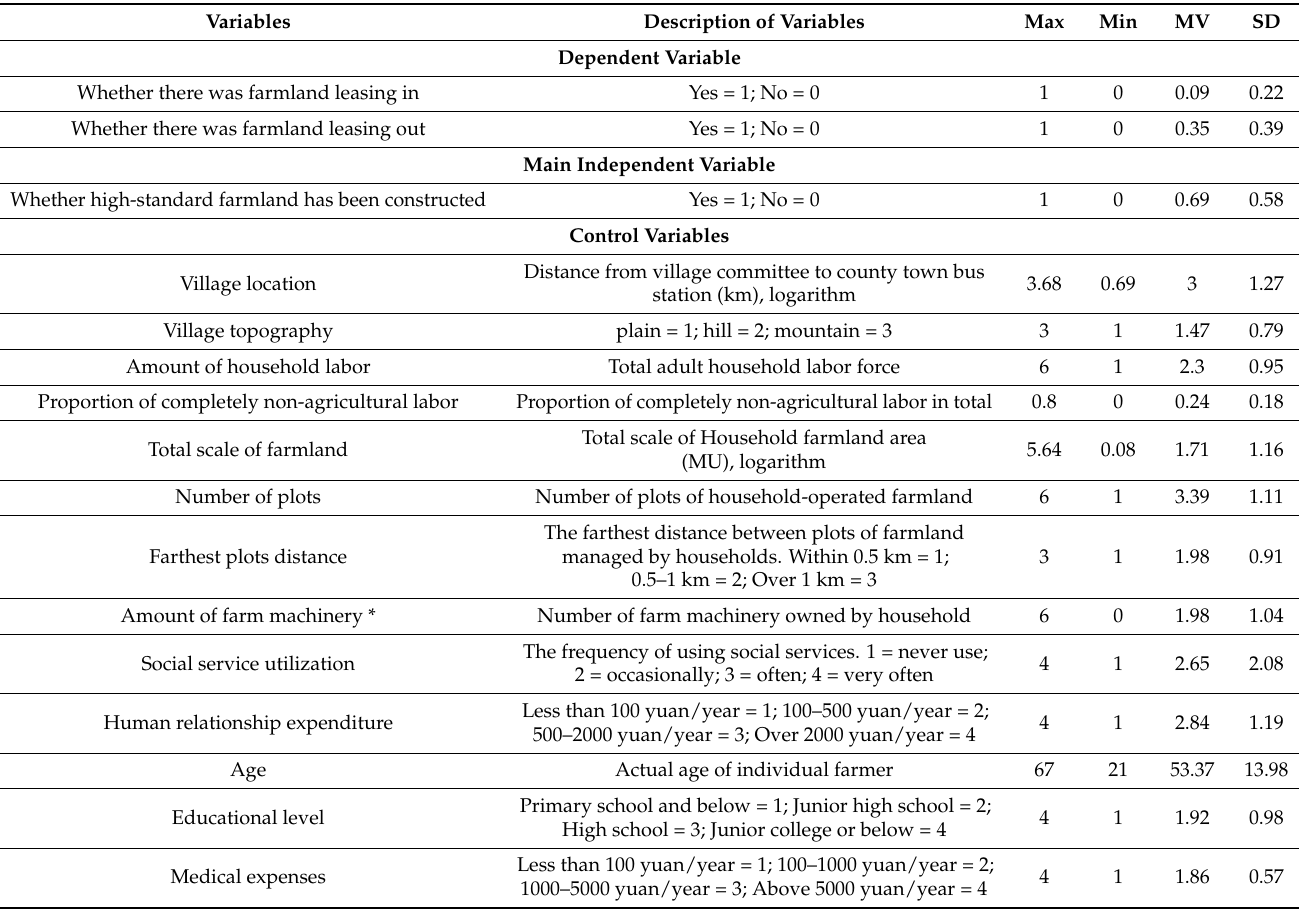
Table 1. Descriptive Statistical